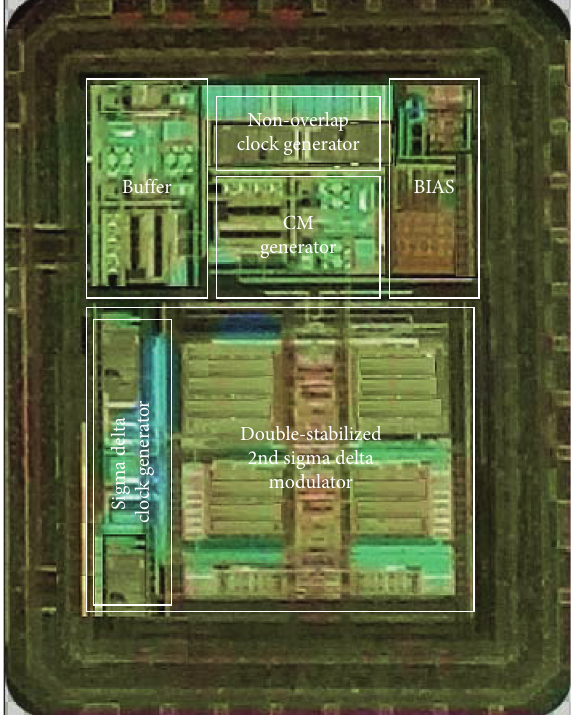
Figure 8: Micrograph of transmitter